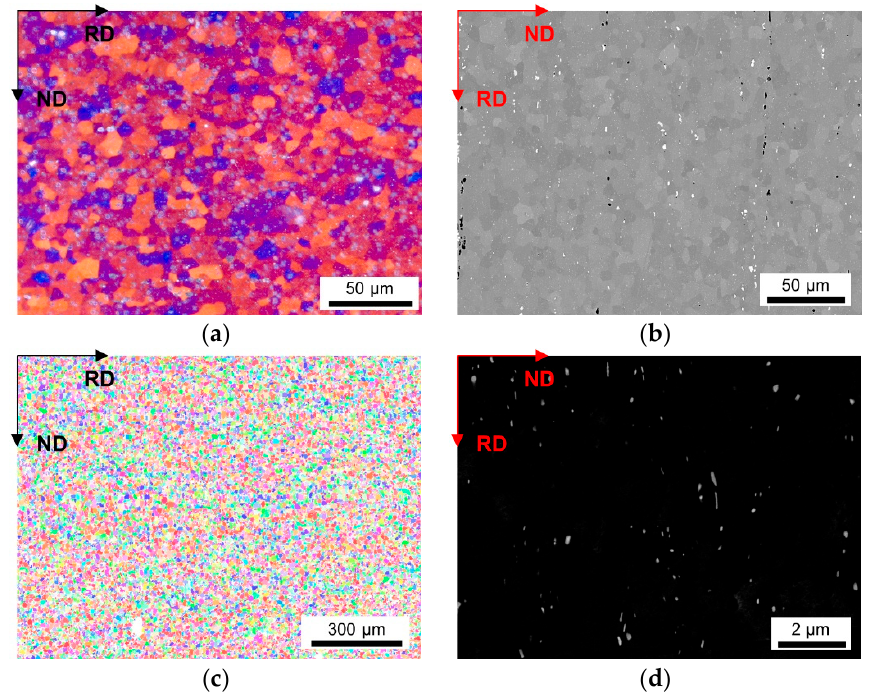
Figure A15. Microstructure of the soft annealed LFe-HMn cast under NR-C conditions, homogenized at 550 °C and cold rolled to a CRD of 63%. ( a ) LOM. ( b ) BSE image. ( c ) EBSD IPF map in RD–ND plane. ( d ) BSE micrograph showing dispersoids.